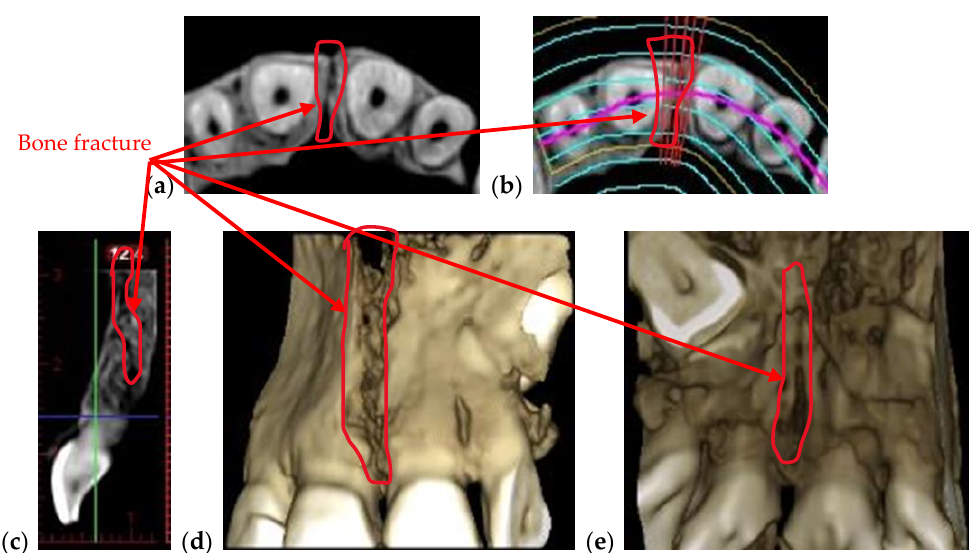
Figure 3. 3D CBCT of a fractured maxillary in different views: ( a ) axial view; ( b ) axial view indicating the position of the fracture; ( c ) sagittal view; 3D reconstruction, ( d ) frontal and ( e ) posterior view, previously detailed in [28]. Patient V.L., female, age 29 years, diagnosed with a crack in her maxillary bone caused by a head trauma.